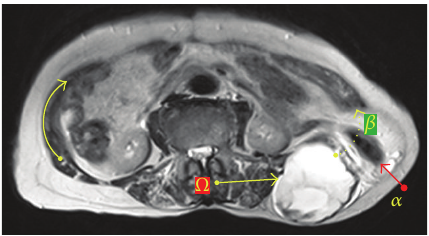
Figure 1: MRI imagining shows tumor (omega arrow), herniated descending colon (alpha arrow), and abdominal wall defect (dotted beta